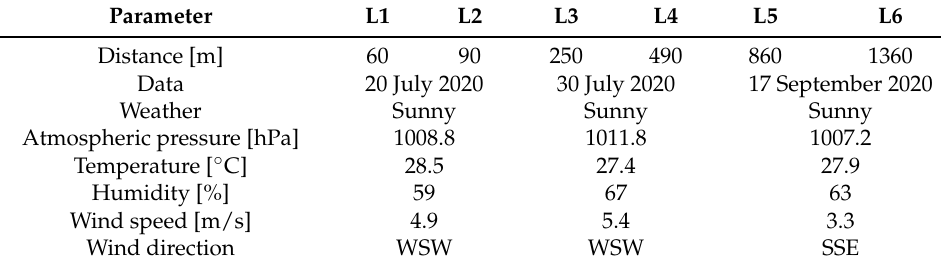
Figure 8. Ground communication experiment of six sections. Table 4. Experiment dates and distances of respective